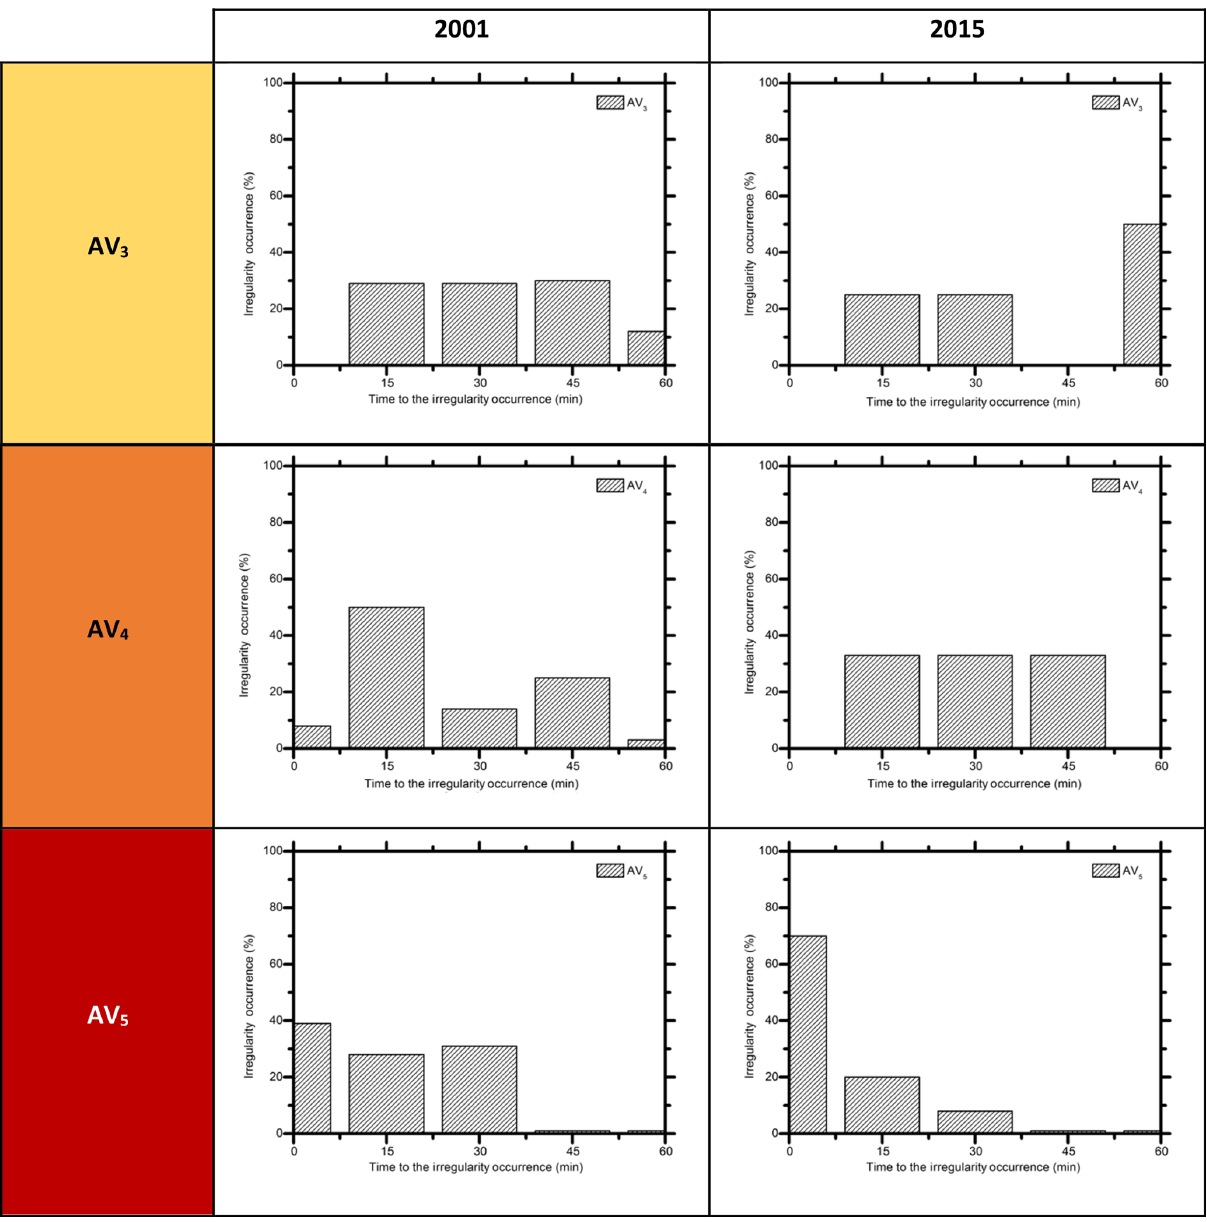
Figure 2. The time relationship between the V zp parameter, considering the AV 3 , AV 4 , and AV 5 indexes, and the irregularity observations in ionograms in the summer of 2001 and 2015 over São